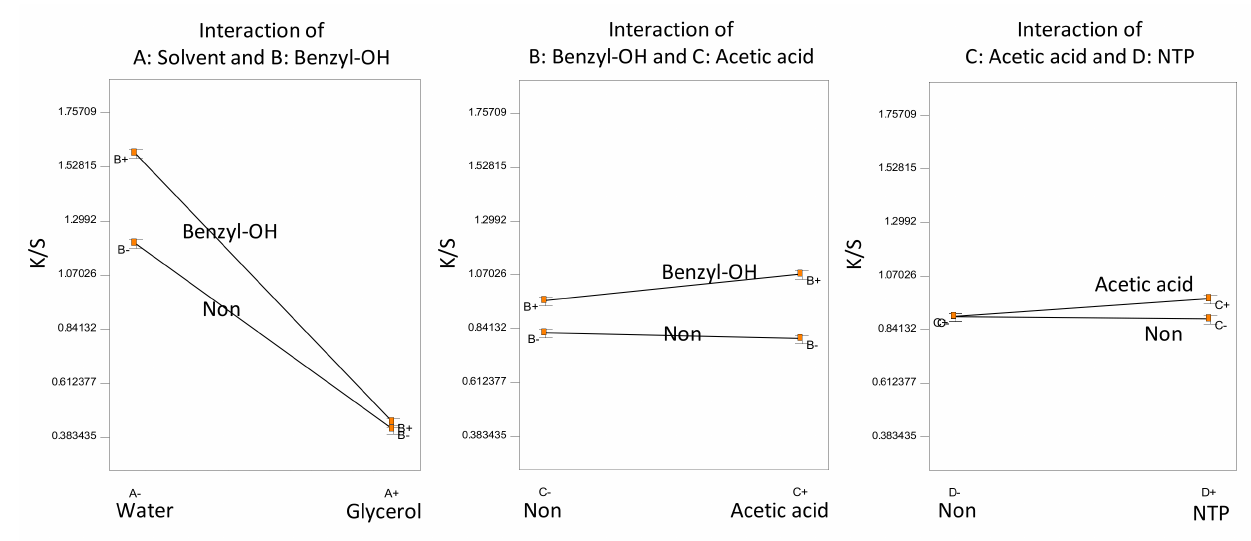
Figure 2. Statistical inference of Experiment A: significant factorial interactions.